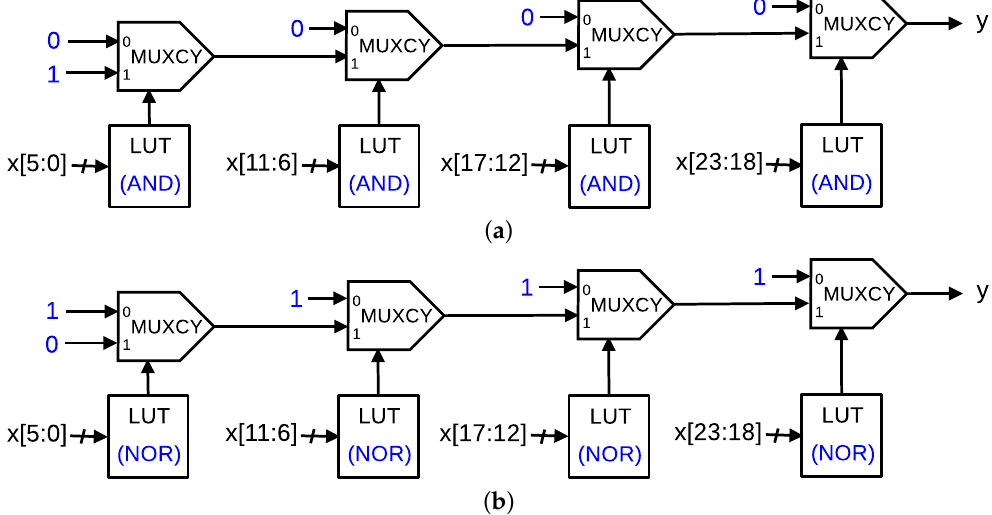
Figure 3. Examples of the implementation of wide input functions using carry chains: ( a ) 24-input AND and ( b ) 24-input